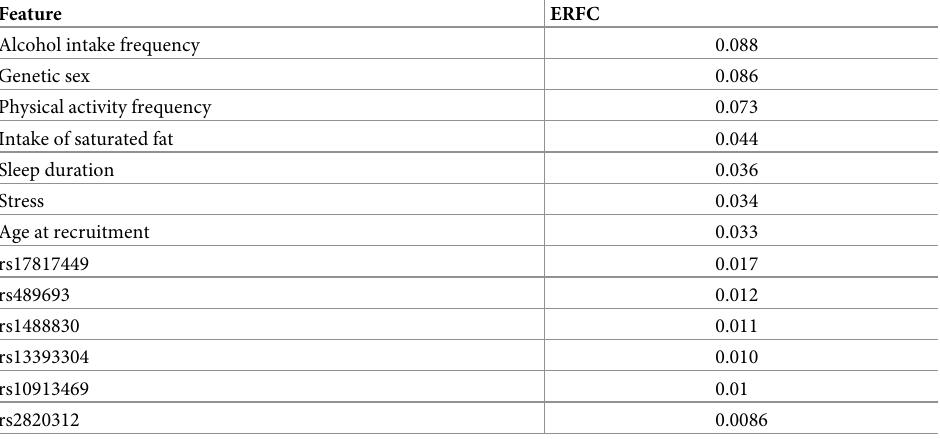
Table 3. The resulting ranking based on the expected relative feature contribution (ERFC) for the particular XGBoost model investigated based on training data consisting of 64 000 individuals from UK